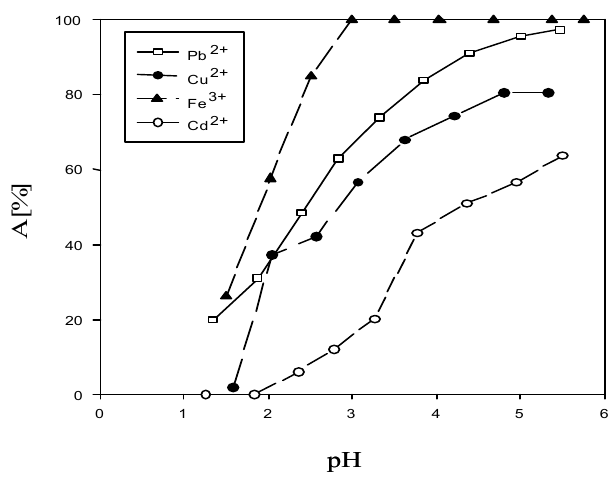
Materials 2017 , 10 , 857 14 of 32